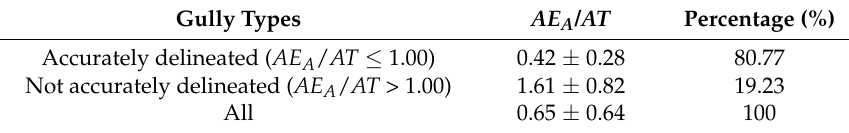
Table 2. Division of gully interpreting accuracy based on the AE A / AT index (mean ± SD). Gully Types